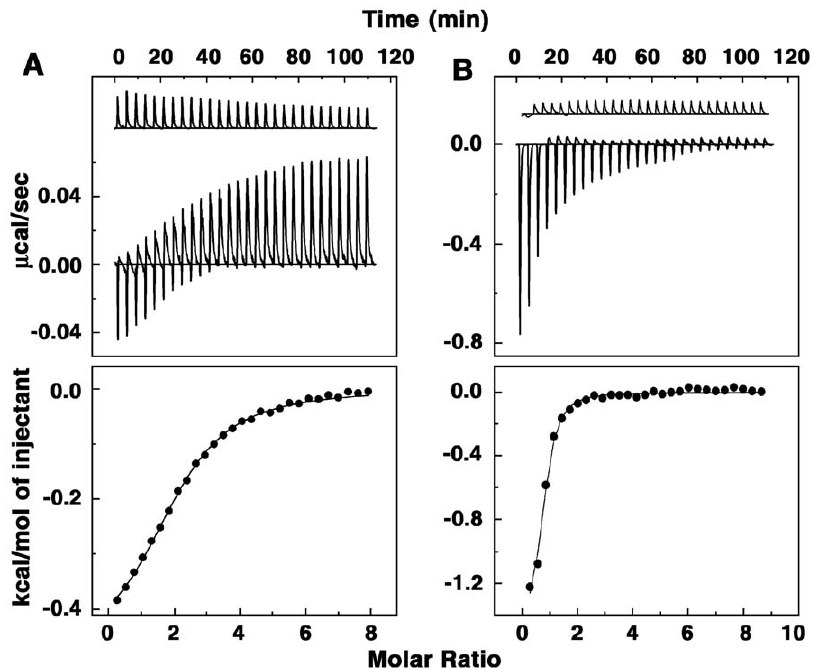
Figure 7. ITC profiles for the binding of (A) ADG and (B) DAU with tRNA. The top panels represent the raw data for sequential injection of tRNA into drug solution and the bottom panels show the integrated heat data after correction of heat of dilution against molar ratio of poly(A)/drug. The data points (closed circle) were fitted to a one site model, and the solid lines represent the best fit data.